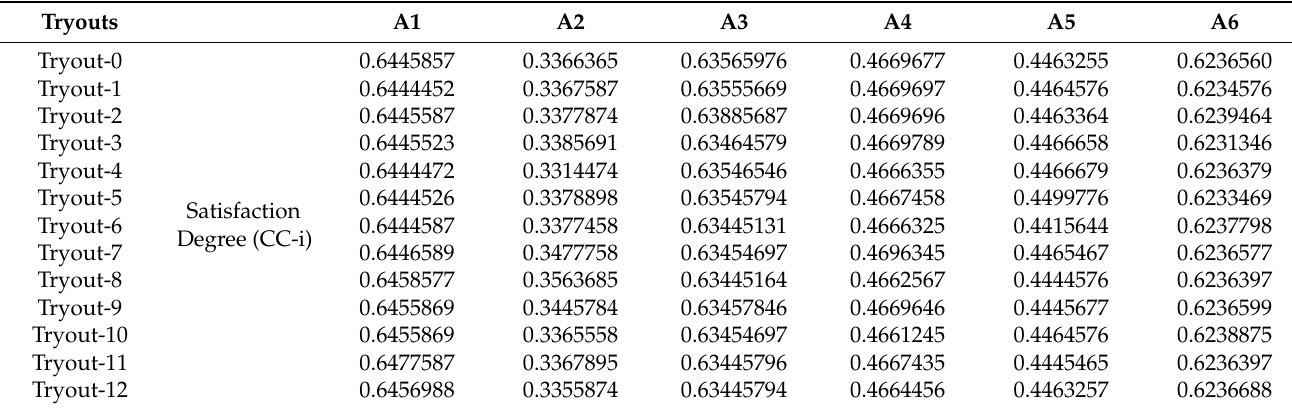
Table 10. Sensitivity Analysis.